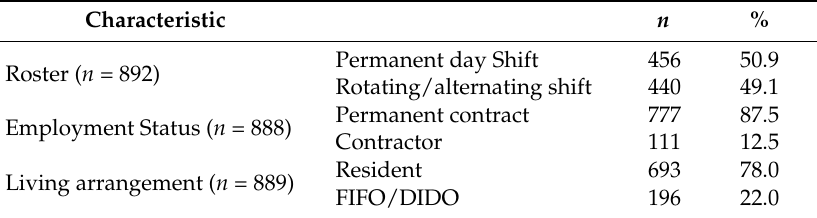
Table 1. Participant employment characteristics.